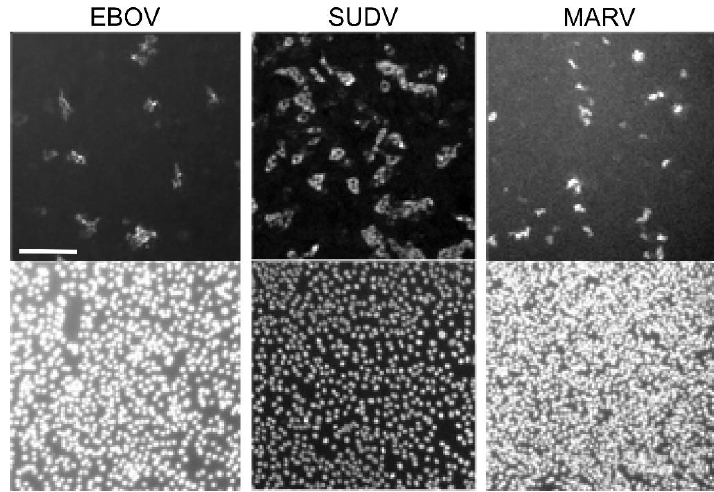
Figure 5. Representative images of FFU (Focus-Forming Unit) assays in EBOV, MARV, and SUDV. Here, a representative image for EBOV (left), SUDV (middle), and MARV (right) is shown. Scale bar shown on EBOV image is representative for all images, 0.2 µm. Both nuclei (Hoechst 33,342, bottom) and immunostained viral protein (top) are pictured here. Viral titers are calculated by using a free, open-source software, CellProfiler, to count foci and nuclei. Foci generally consist of 2–5 cells. Sudan virus shown here consisted of 2–8 cells per foci. For example, the full SUDV image produced a foci count of 530 and a nuclei count of 8587. The CellProfiler output image has been included as Supplementary Figure S1. Comparison of the assays showed consistent performance irrespective of the virus strain used. The CVMO and NRAO assays were consistently in close agreement with titers being less than 3-fold apart. In comparison, TCID 50 titers were consistently lower, by up to 10-fold and the FFU assay titer was 10- to 15-fold higher than the plaque assays (Figure 6). These differences could be due to the nature of titer determination for the assay. For